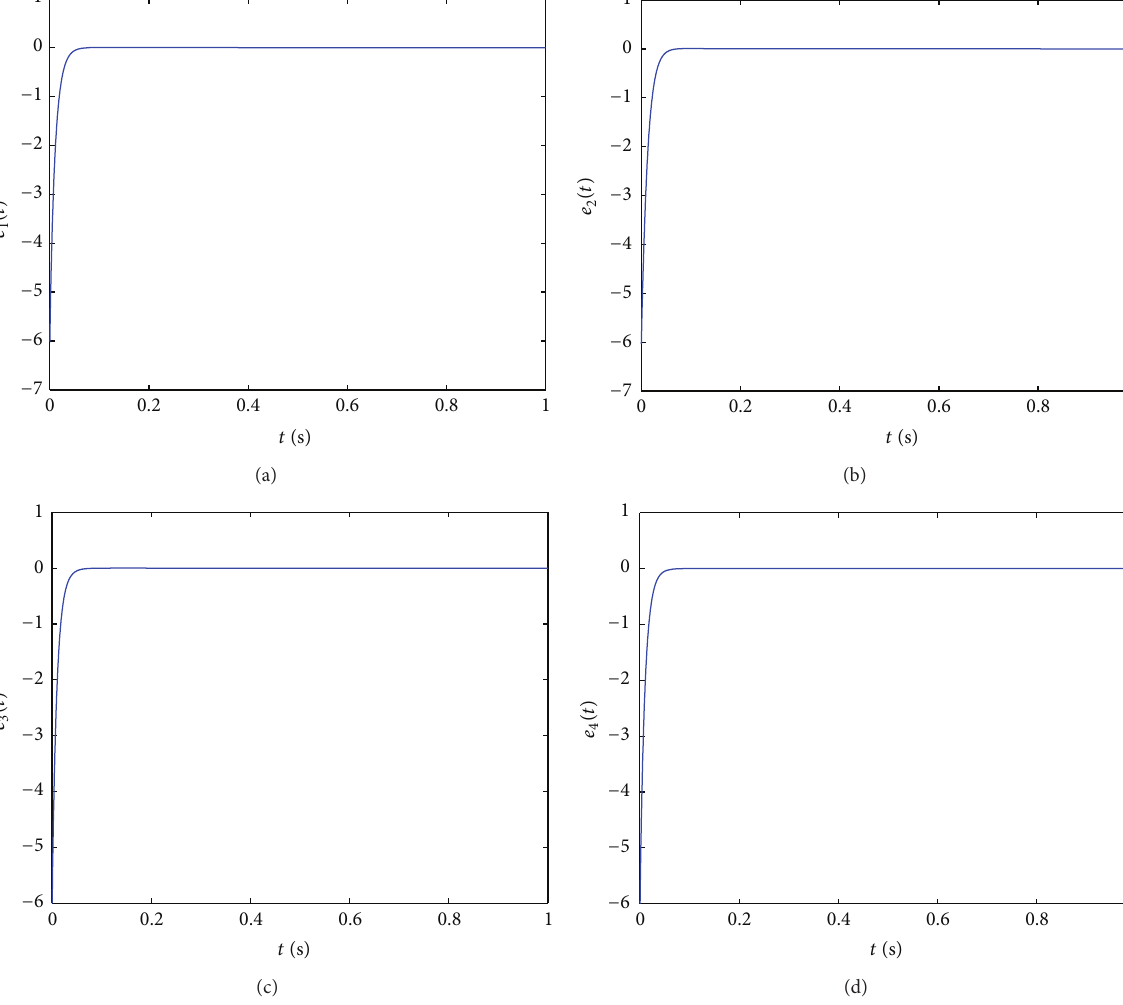
Figure 2: Time waveforms of synchronization errors 𝑒 1 (a), 𝑒 2 (b), 𝑒 3 (c), and 𝑒 4 (d) between two fractional-order hyperchaotic Chen